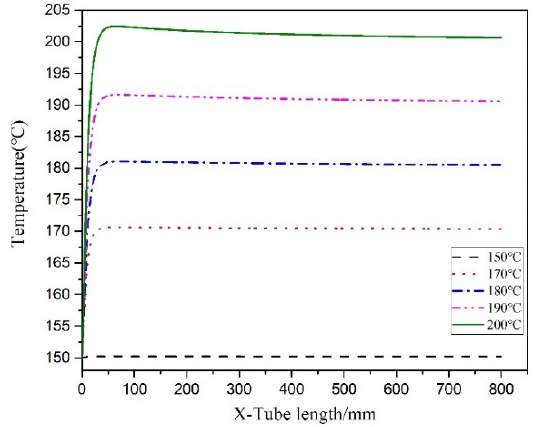
Figure 11. Temperature distribution cloud diagram of the axial section of the microreactor at different jacket temperatures.